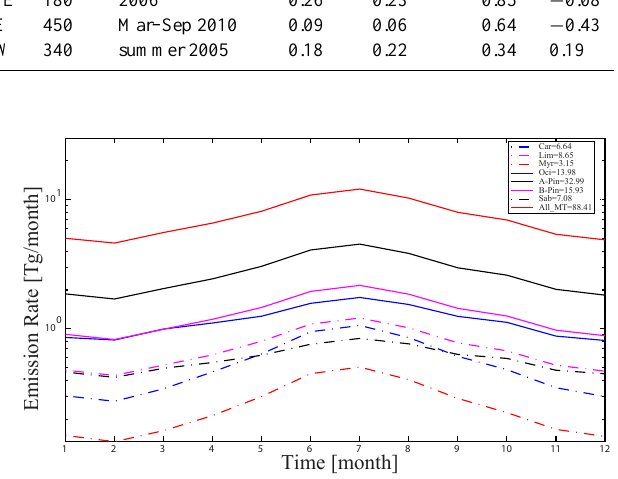
Fig. 2. Monthly emission rates (Tgmonth − 1 ) for seven monoter- pene compounds (alpha-pinene, beta-pinene, limonene, myrcene, sabinene, delta3-carene and ocimene), together with cumulative to- tal (All) calculated by MEGAN, in a domain covering the Northern Hemisphere, for 2006. Annual fluxes (Tg) of each compound are also